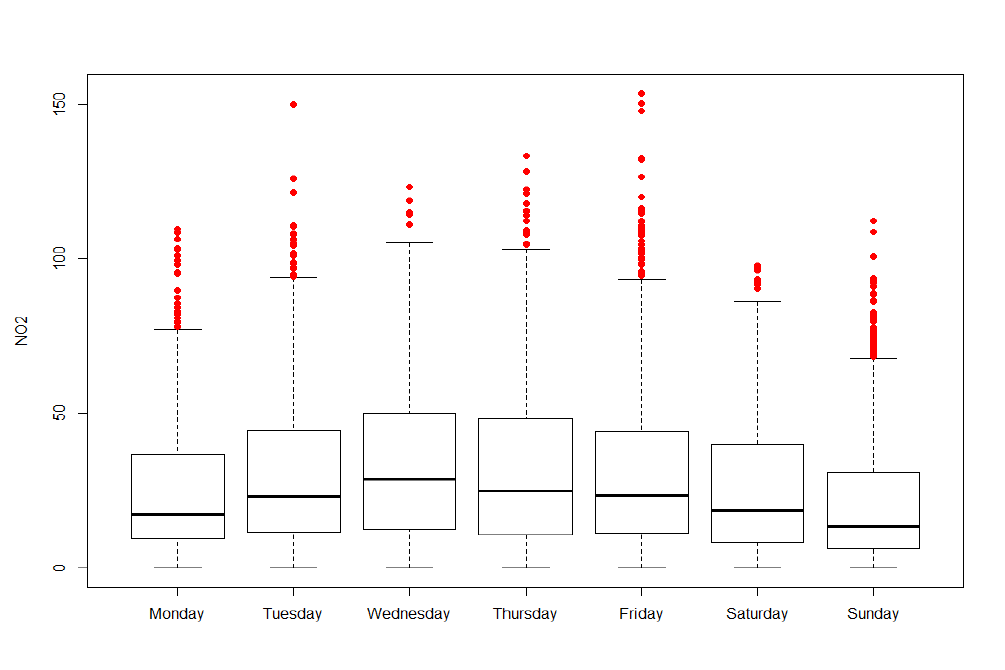
Figure 12. Daily analysis of NO 2 concentrations at Blanchardstown air quality monitoring station. Software: R-programming